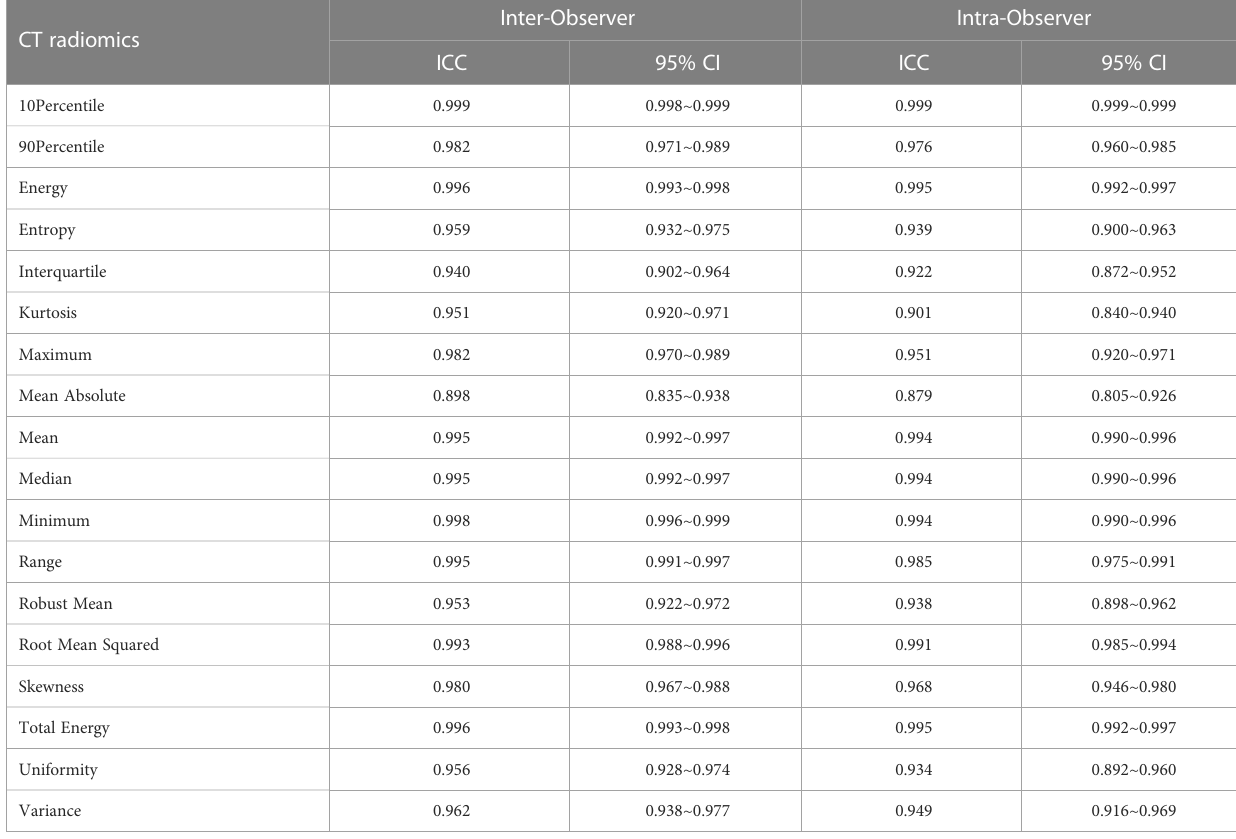
TABLE 2 ICC and 95% con fi dence interval (CI) of the two radiologists extracting fi rst-order features of 3D lesions in FBP image.